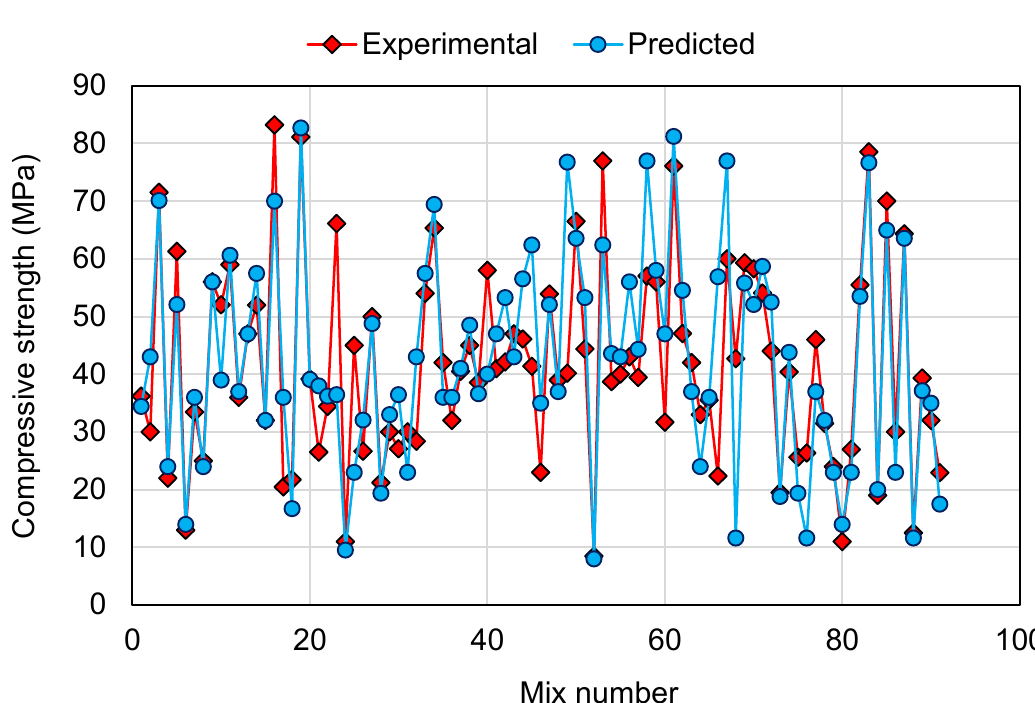
Figure 14. Comparison of experimental and predicted results for the decision tree model.